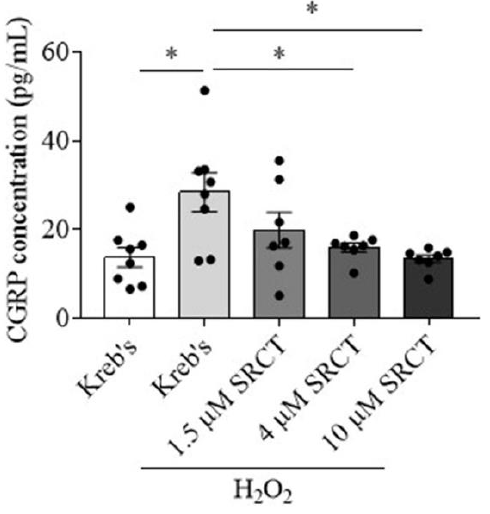
Figure 2. Saracatinib reduced CGRP release induced by H 2 O 2 in the mouse TG. Effects of Kreb’s ( n = 8); 1 mM H 2 O 2 ( n = 8); 1.5 µ M ( n = 7), 4 µ M ( n = 7), or 10 µ M ( n = 7) saracatinib in the presence of 1 mM H 2 O 2 at 20 min post treatment on CGRP release (pg/mL). Abbreviations: saracatinib (SRCT). Two-tailed unpaired t -test was used for the comparison in CGRP release between the H 2 O 2 group and either the Kreb’s group or the saracatinib in the presence of H 2 O 2 group. Significant differences were labeled as * p <